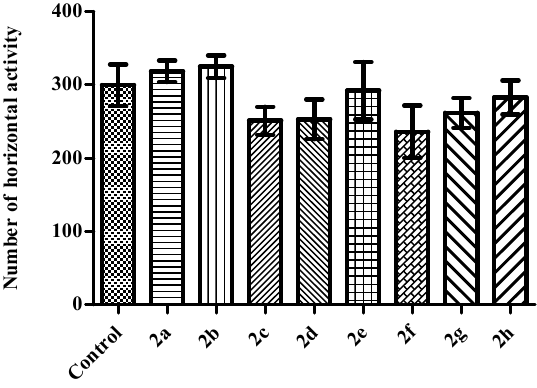
Figure 6. The effects of the test compounds ( 2a – 2h ) on the horizontal locomotor activities of the mice in the activity cage test. Values are presented as mean ± SEM, ( n = 7).